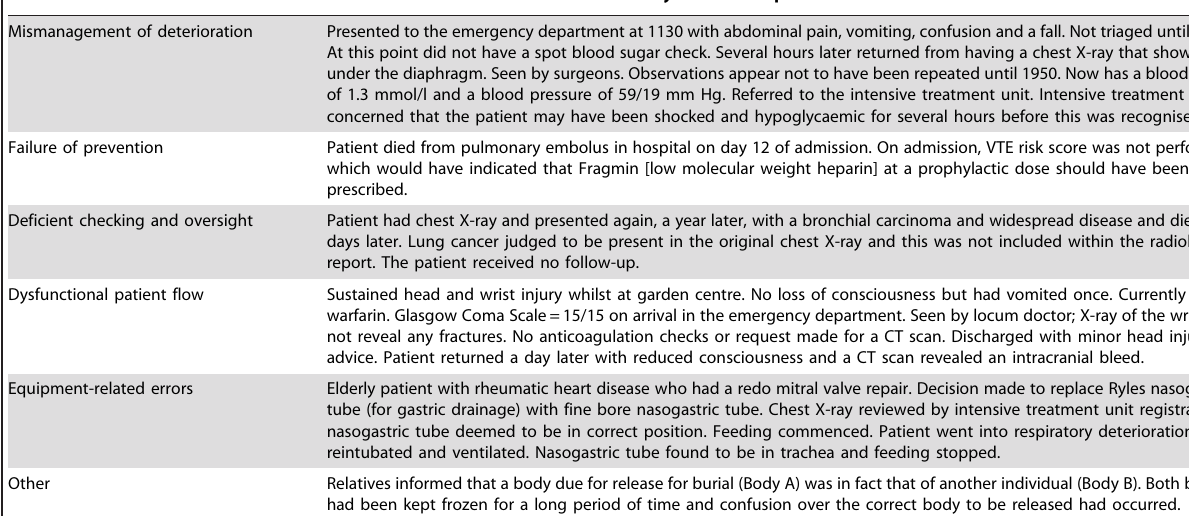
Table 2. Extracts of free text from patient safety incident reports of